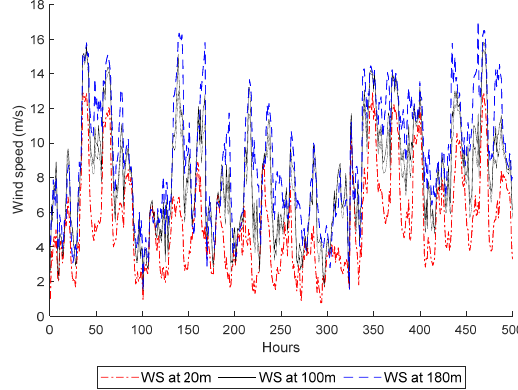
Figure 2. Measured wind speed at 20m, 100m, and 180m